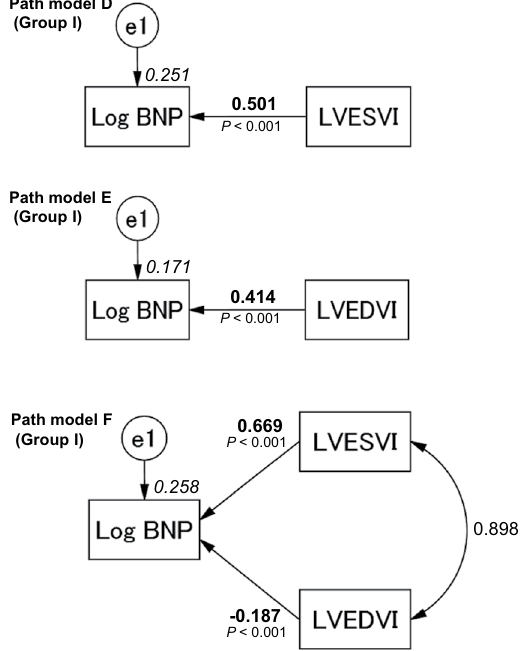
Figure 2. Path models D–F. The paths are displayed with the coefficients that indicate the standardized coefficient of the regressing independent variable on the dependent variable of the relevant path (path model D, LVESVI to Log BNP; path model E, LVEDVI to Log BNP; path model F, LVESVI and/or LVEDVI to Log BNP) in Group I. These variables are the standardized regression coefficients (direct effect), squared multiple correlations [on the upper right side of rectangles (in italics)] and the correlations between each of the variables. Other variables included in the covariance structure analysis are presented in Supplemental Tables 5, 6, and 7. BNP, B-type natriuretic peptide; LVESVI, left ventricular end-systolic volume index; LVEDVI, left ventricular end-diastolic volume index; and e, extraneous variable.